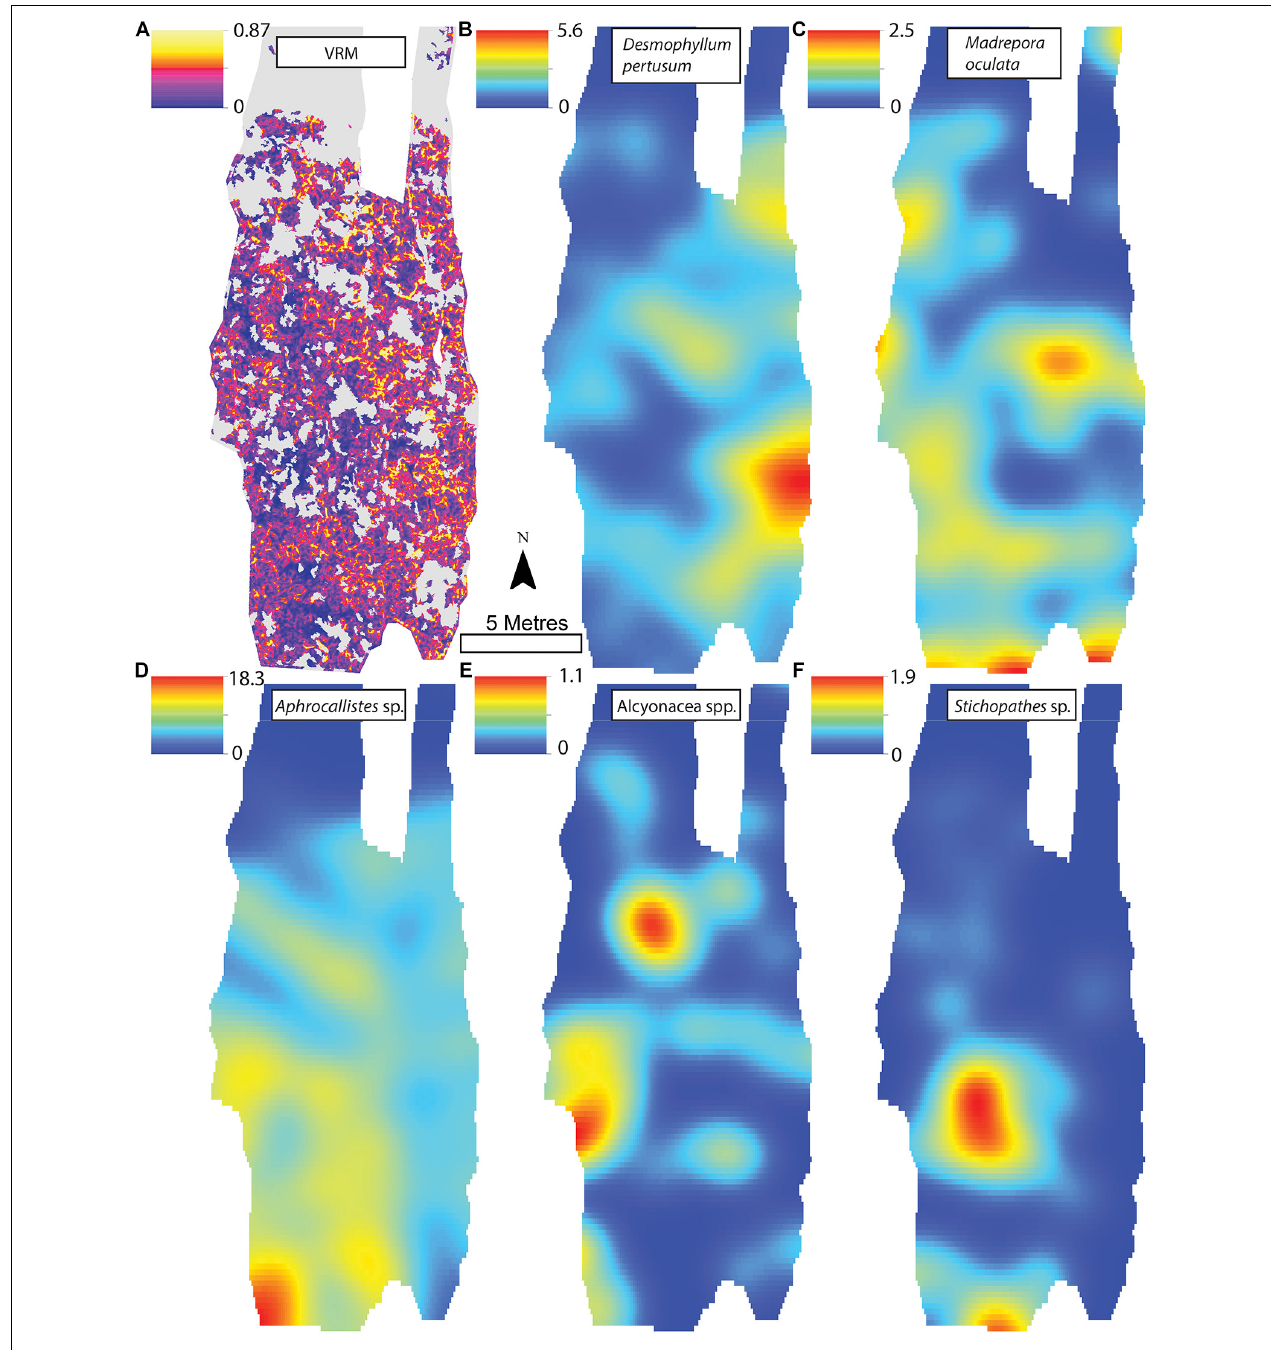
FIGURE 8 | (A) Vector Ruggedness Measure values for reef facies. Kernel estimate of intensity plots (number of individuals per m 2 and sigma = 1) (B) Desmophyllum pertusum , (C) Madrepora oculata , (D) Aphrocallistes sp., (E) Alcyonacea spp., and (F) Stichopathes sp. for Site B. The non-reef substrate is in grey. Note varying colour scale between the different